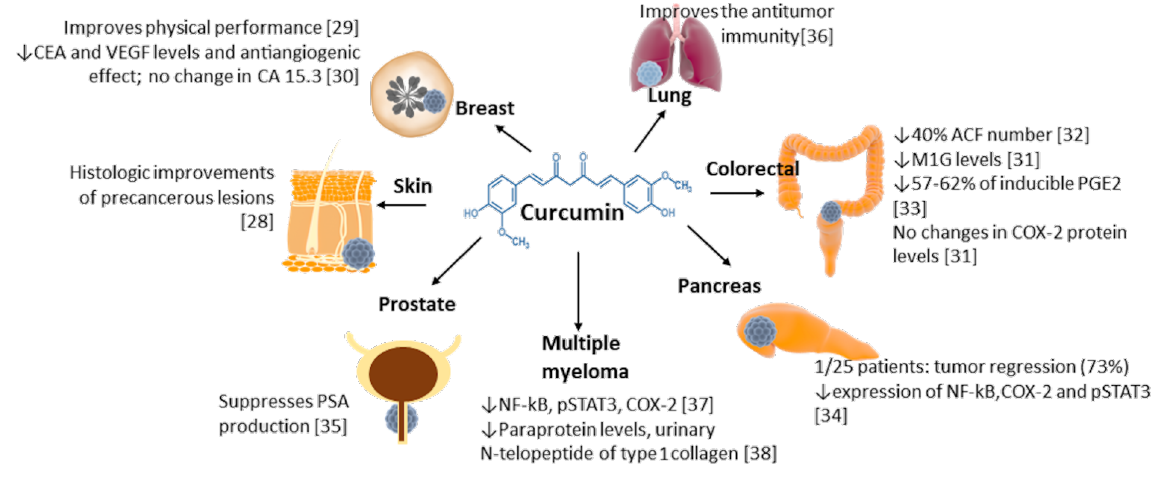
Figure 1: Effects of CUR on cancerous processes observed on clinical trials [28-38]. Carcinoembryonic antigen (CEA); vascular endothelial growth factor (VEGF); cancer antigen 15.3 (CA15.3); DNA adduct 3-(2-deoxy- β -di- erythro -pentafuranosyl)pyrimido[1,2- α ]purin-10(3H)-one (M1G); enzyme cyclooxygenase-2 (COX-2); colorectal aberrant crypt foci (ACF); prostaglandin E2 (PGE2); 5-hydroxyeicosatetraenoic acid (5-HETE); phosphorylated signal transducer and activator of transcription 3 (pSTAT3); monoclonal gammopathy of undetermined significance (MGUS); nuclear factor kappa B (NF- κ